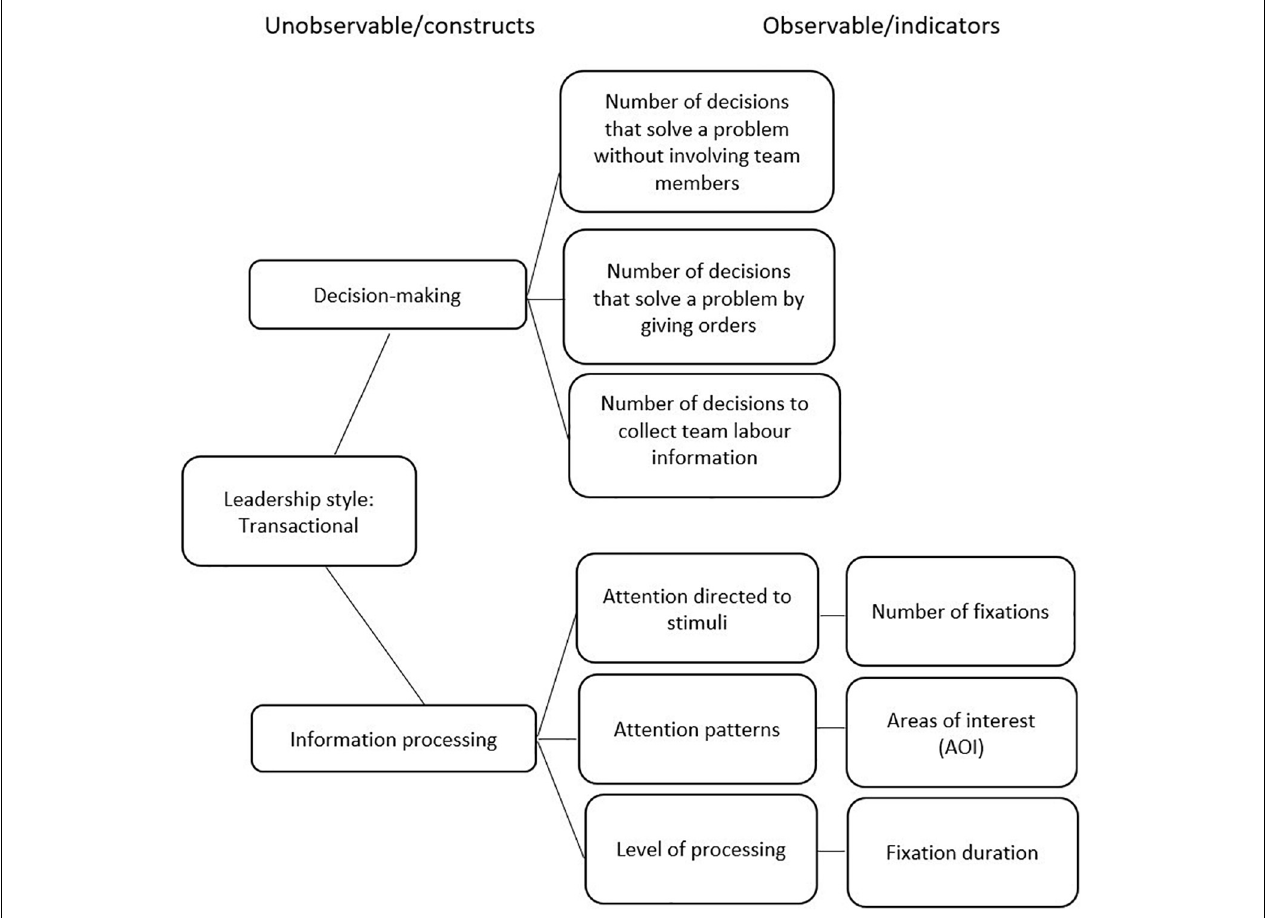
FIGURE 3 | Transactional